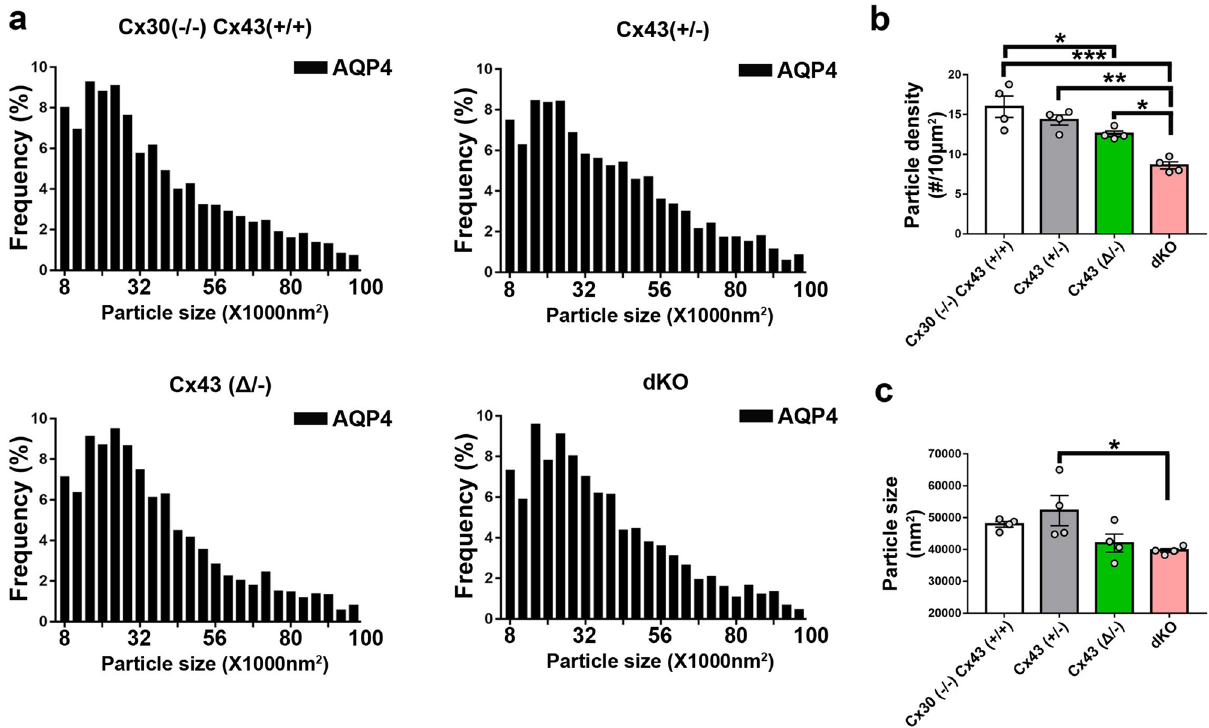
Figure 5. Distribution of AQP4 in endfeet of Cx43 transgenic mice. ( a ) Histograms showing size distributions of all AQP4 particles measured in each genotype. (n = 4 mice, 6–10 images and -2000–3000 particles analyzed from each genotype). ( b ) Particle densities for AQP4 in perivascular domains from each genotype. Dots represent four individual brains, from which 6–10 sections were analyzed. Note that density of AQP4 particles in perivascular regions was negatively correlated with Cx43 expression in the various genotypes [Cx43 (+/+) > Cx43 (+/−) > Cx43 (Δ/− ) > Cx43 (−/−) ]. ( c ) Sizes of the particles were relatively constant among the genotypes, with only the Cx43 (+/−) differing from the dKO (n = 4 mice, 6–10 images analyzed from each genotype). Data are presented as mean ± SEM (ANOVA followed by Tukey’s post hoc test: * p < 0.05, ** p < 0.01, and *** p <